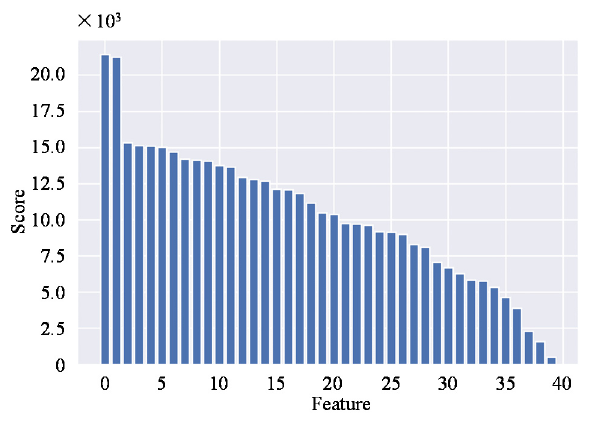
Figure 28. Top 40 most important features .